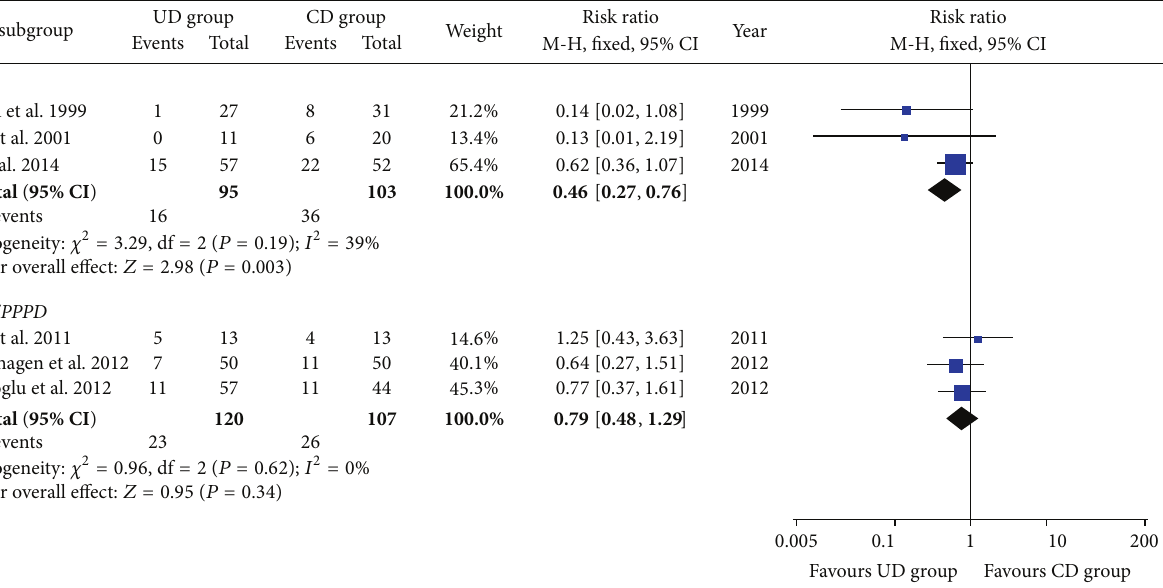
Figure 2: Meta-analyses of pancreatic fistula for DP and PD/PPPD.